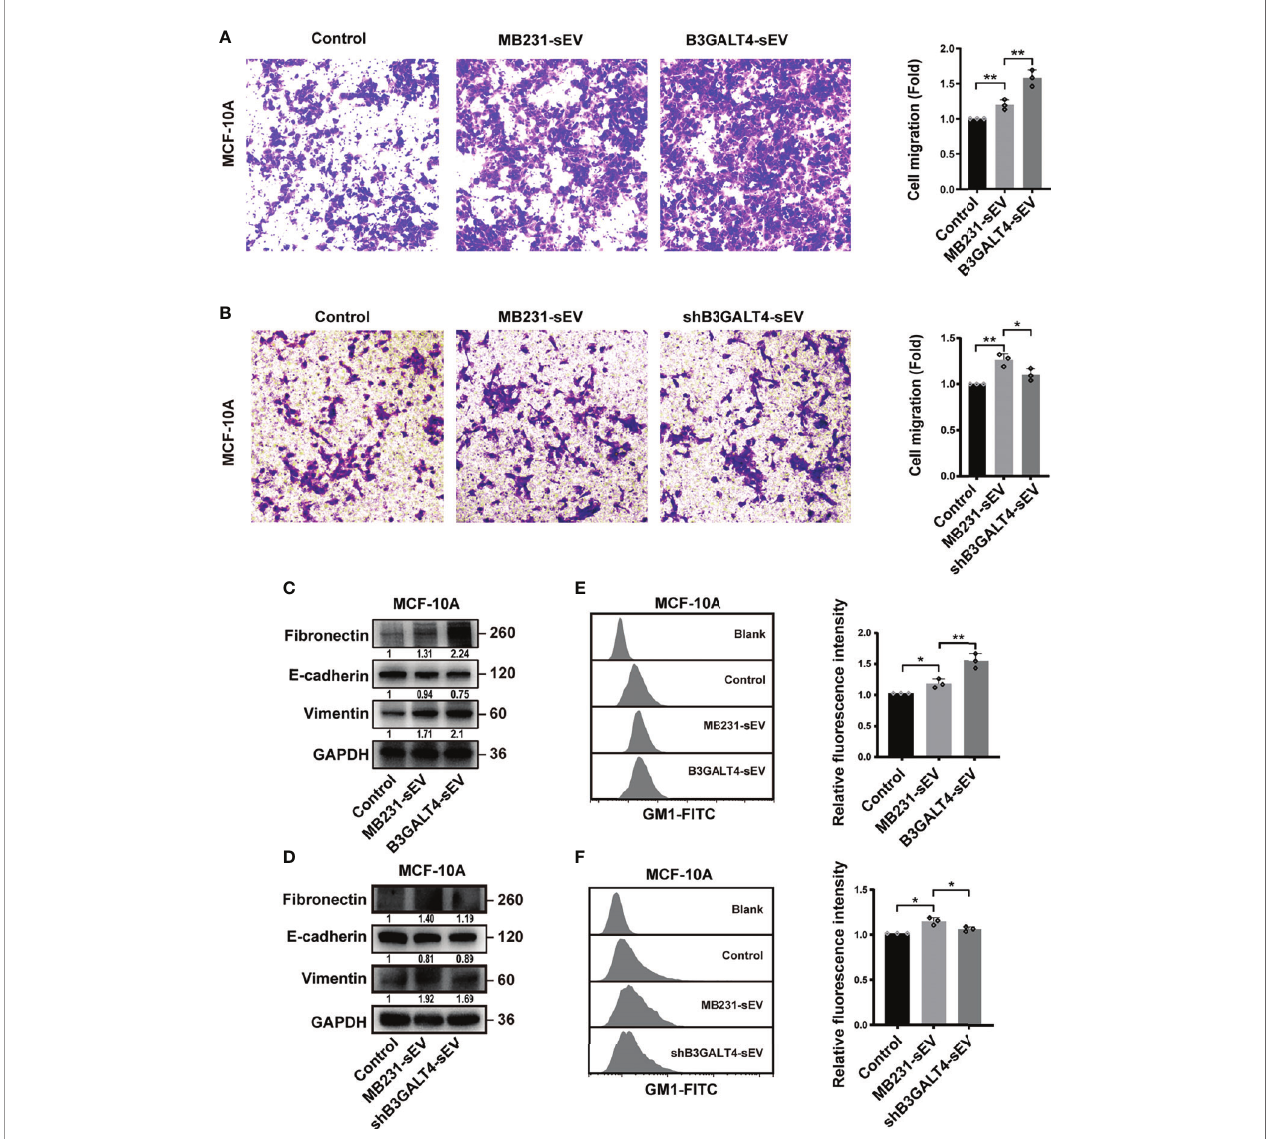
FIGURE 5 | GM1-enriched sEV-induced EMTprocess ofrecipient cells. (A, B) The migratoryability of MCF-10A cellstreated with B3GALT3-sEV (A) and shB3GALT4-sEV (B) . (C,D) Expression of fi bronectin, E-cadherin,and vimentin inMCF-10A treated with B3GALT3-sEV (C) and shB3GALT4-sEV (D) . (E, F) The expression ofGM1 inMCF- 10A cells treated with B3GALT3-sEV (E) andshB3GALT4-sEV (F) , evaluated by fl ow cytometry. Blankindicates unstained MCF-10A or MCF-7 cells. Control indicates recipient cellsstained with CTB-Biotin. MB231-sEV, B3GALT4-sEV, and shB3GALT4-sEV indicate recipientcells with thecorresponding sEV treatment stained with